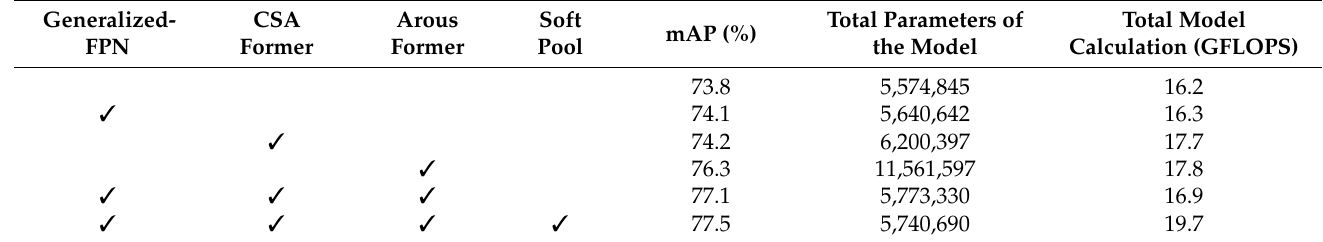
Table 1. Comparison of ablation